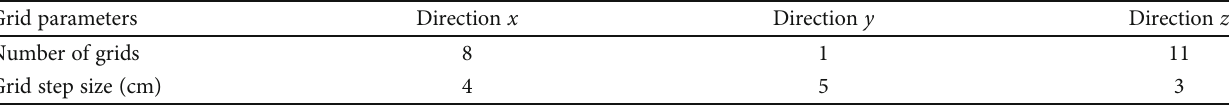
Table 3: Mesh parameters of the ideal model for numerical simulation.